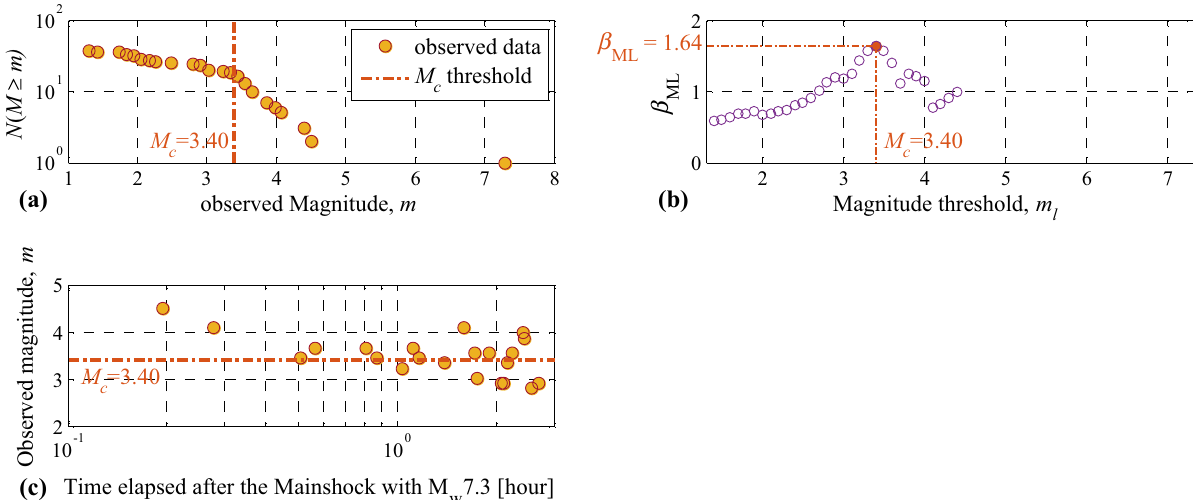
Figure 3. The three methods (Section SI-3-Results) for estimation/validation of M c for the first